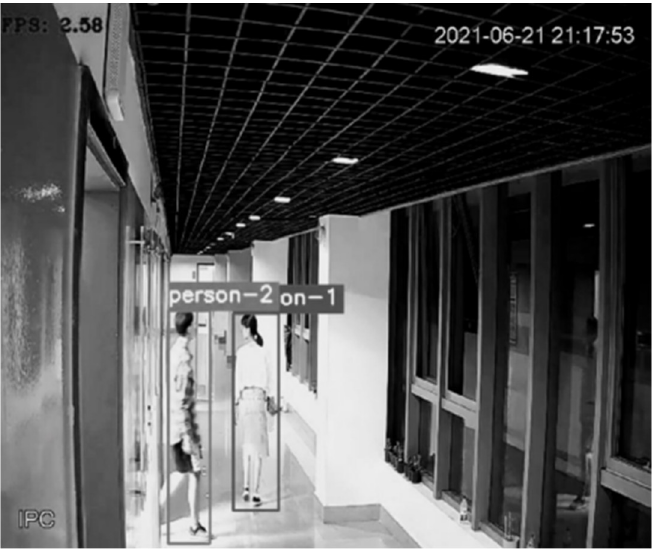
Figure 3. Visual target tracking results.